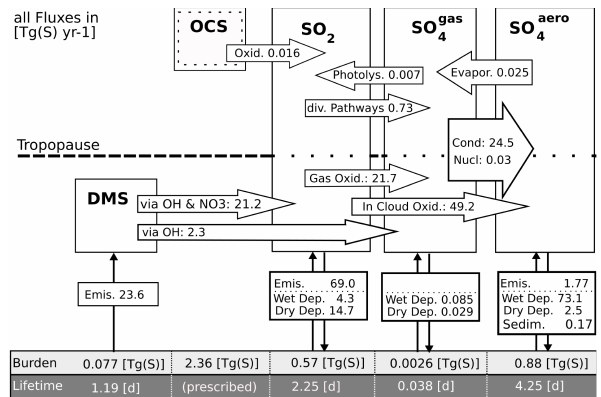
Fig. 1. Schematic budget diagnostics of model prognostic sulphur constituents in the last year of integration. All fluxes are expressed as Tg ( S ) yr − 1 , vertically integrated global mean column masses (burdens) asTg ( S ) , and whole atmosphere lifetimes as